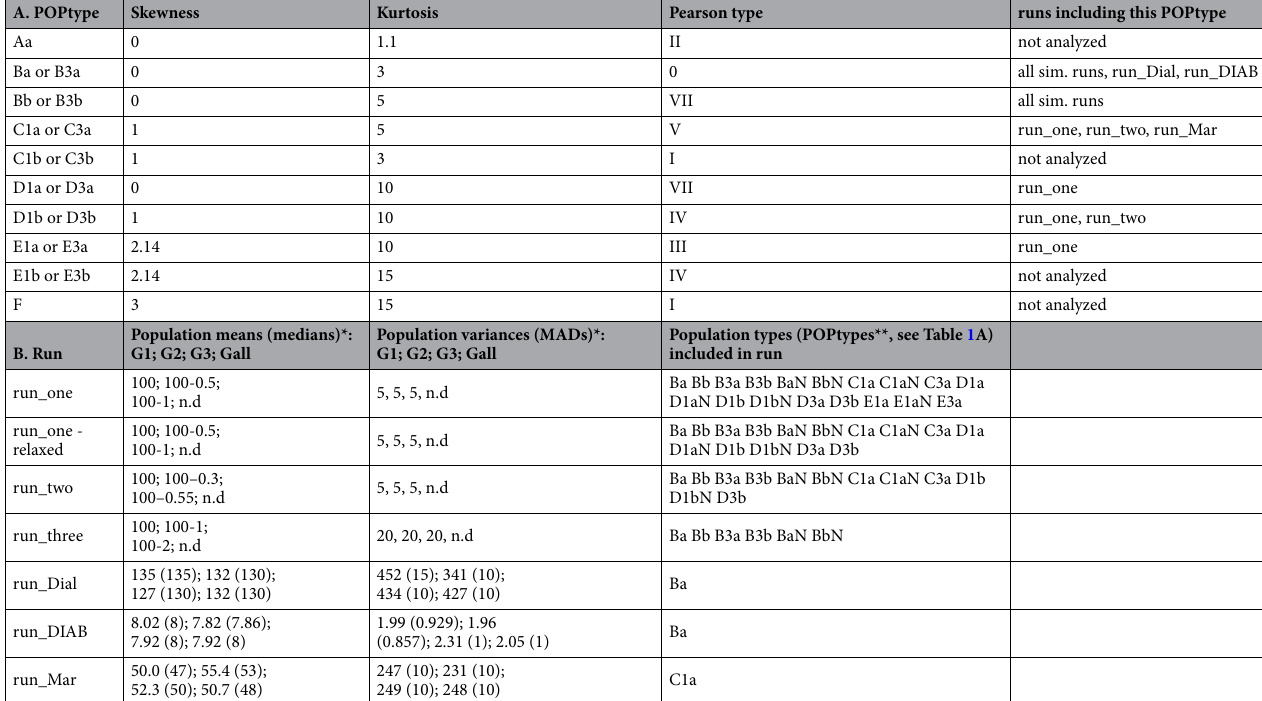
Table 1. A. Definitions of types of populations (POPtype) analyzed, including Pearson types ("POPtype" columns are also found in the skewdf dataframe and in mydfsample samples files). Populations with POPtype suffix including "3", e.g. B3a, had instructions for normalisation. B . Run absolute effect sizes and variances for all population groups together (Gall) and groups G1, G2 and G3. (run_onerelaxed created similarly to run_one but without reference to ANOVA assumptions.) Populations with POPtype "N" suffix had group G3 with normal moments. MAD Median absolute deviation (R mad(, constant = 1) ); n.d. = not determined; * For simulation runs, means and variances were set (these were not determined for all groups together and medians/MADs were not determined); for medical study runs (run_Dial, run_DIAB and run_Mar): means, medians, variances and MADs were measured. ** POPtypes were set for simulation runs or approximated for medical study runs. For run definitions see text. sim. =